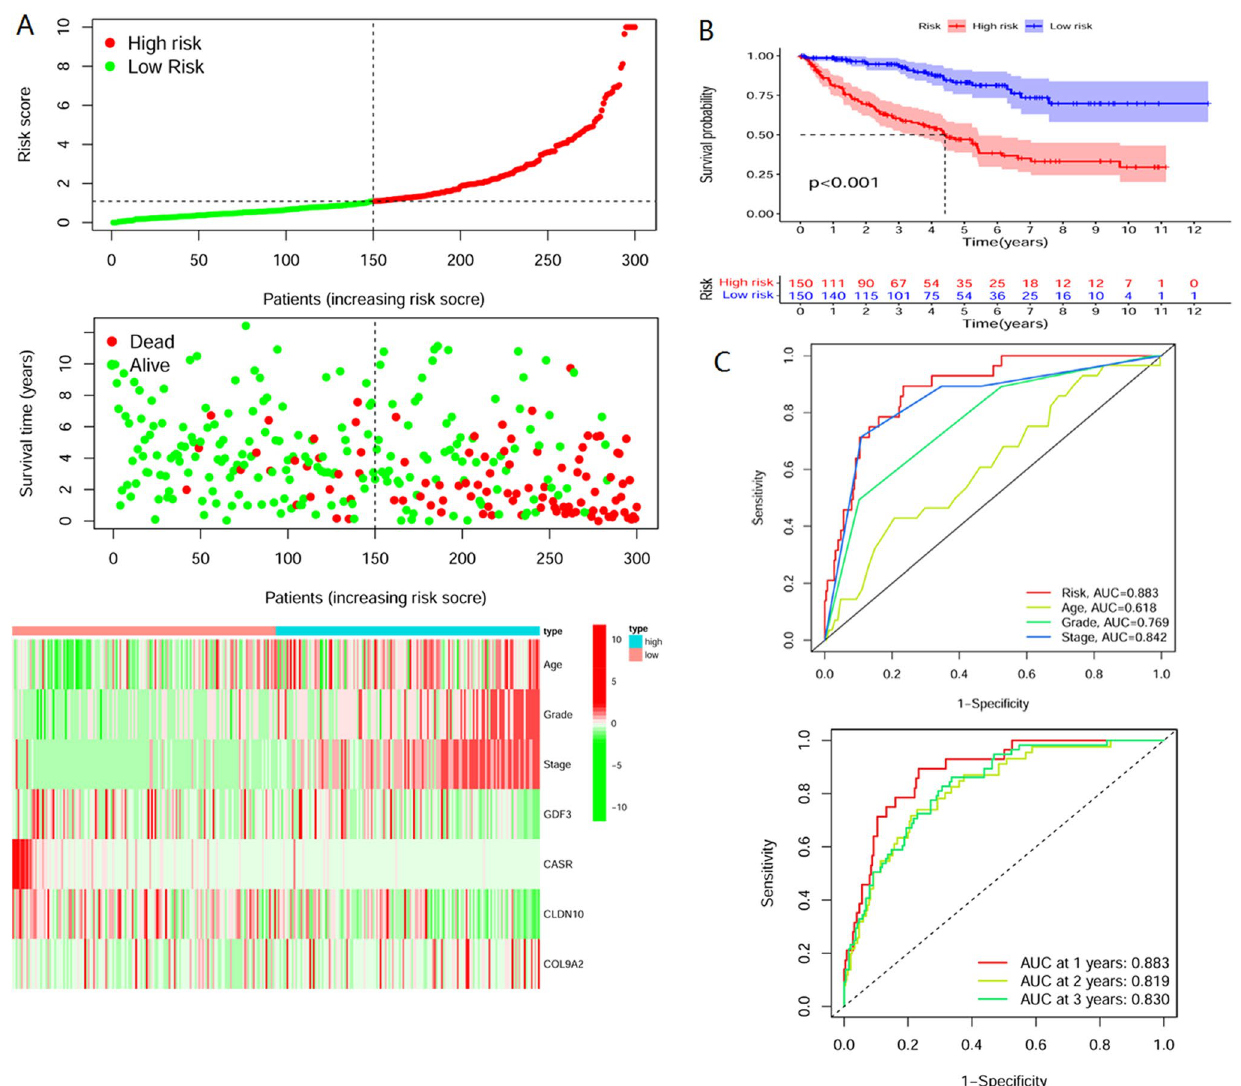
Figure 5. Evaluation of model effects. ( A ) The risk curves are ordered by patient risk, with the left side of the dotted line indicating the low-risk group and the right side indicating the high-risk group. Green points indicate patient survival, and red points indicate patient death. ( B ) Patients were divided into high-risk and low-risk groups, with blue, indicating the low-risk group and red indicating the high-risk group. The survival curves of the two groups are significantly different. ( C ) ROC curves. The area under the curve indicates the model’s accuracy in predicting survival status. The red curve Risk in the figure indicates the accuracy of model prediction in this study, which is higher than the prediction accuracy of age, grade, and stage.